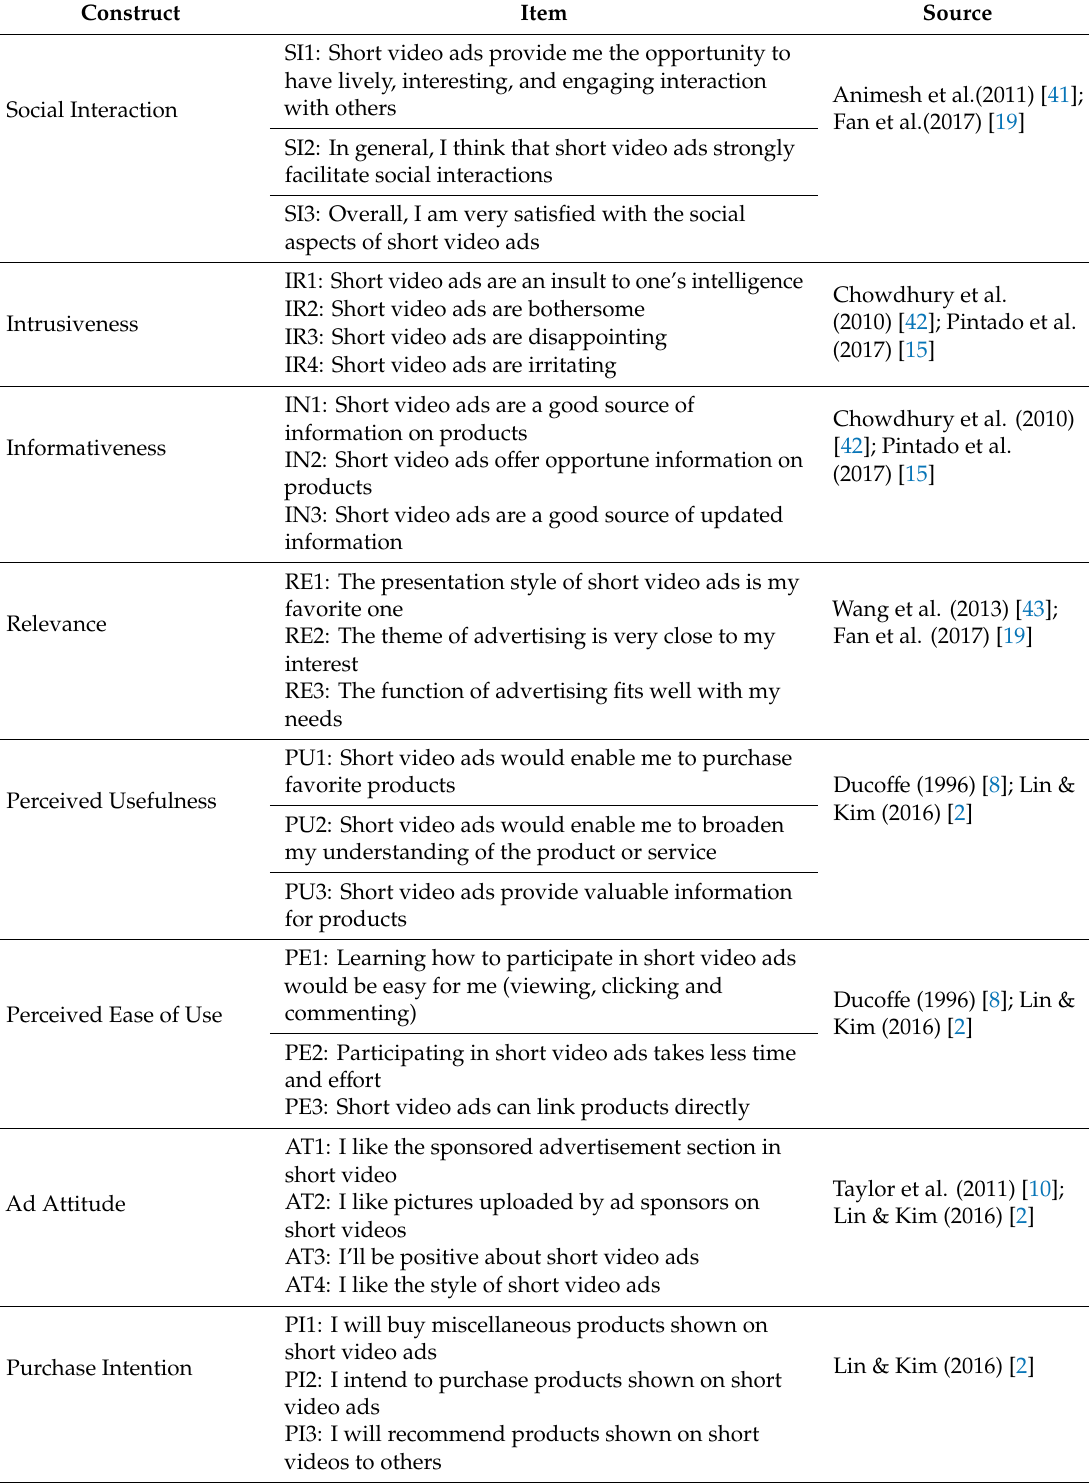
Table 3. Summary of measurement scales constructs (in the table, short video refers to health-related short